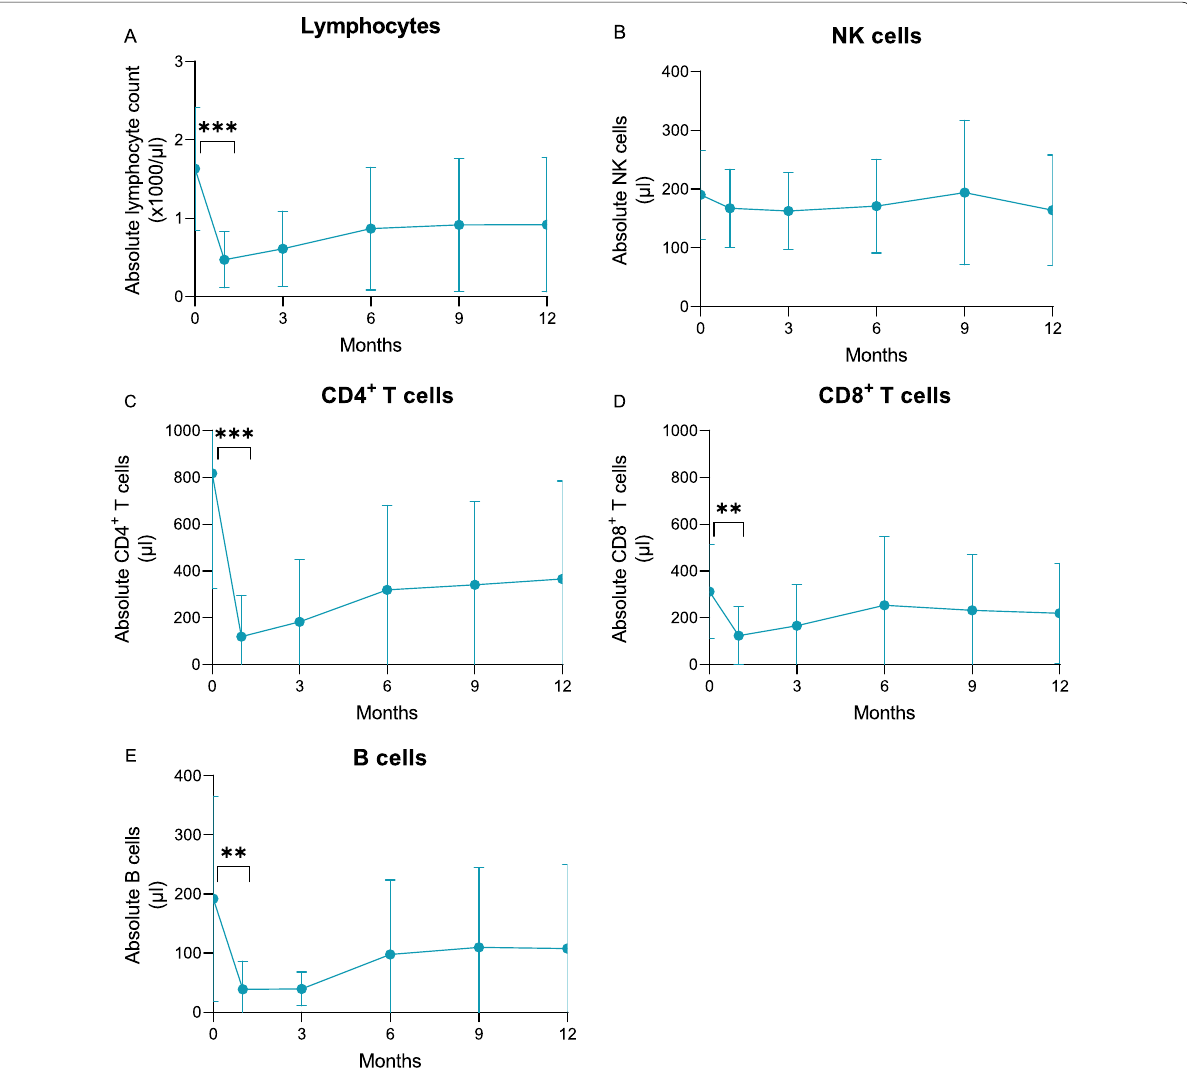
Fig. 4 Measurements of immune cells over time. A decline in absolute lymphocyte count as well as all lymphocyte subgroups was observed within the first month of treatment (total lymphocyte count, part A ; NK cell count, part B ; CD4 + T cell count, part C ; CD8 cell count, part E ), with significant differences in absolute lymphocyte count ( p In the following months of treatment, an increase in lymphocyte count occurred but remained below baseline (part A ). CD4 + T cells remained significantly below baseline throughout the first 9 months (part C ). B cells stayed significantly below baseline throughout the first 3 months (part E ). NK cells, natural killer